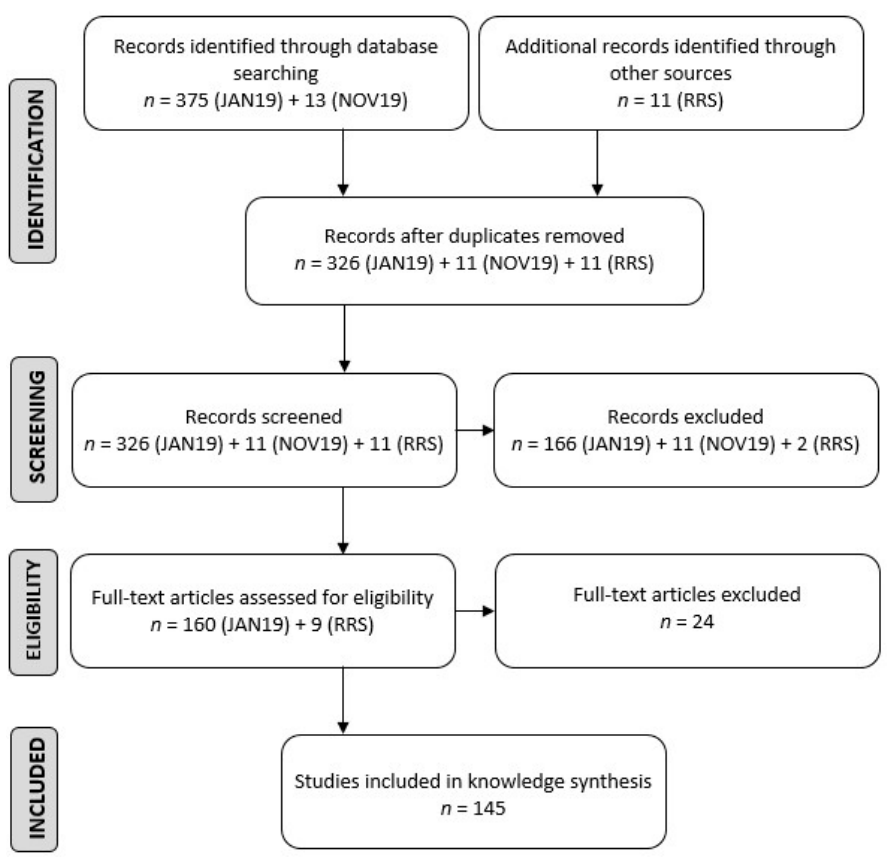
Figure 1. Flow diagram indicating the number of publications reviewed and excluded during each step of the review process, RRS—Reverse Reference Search.